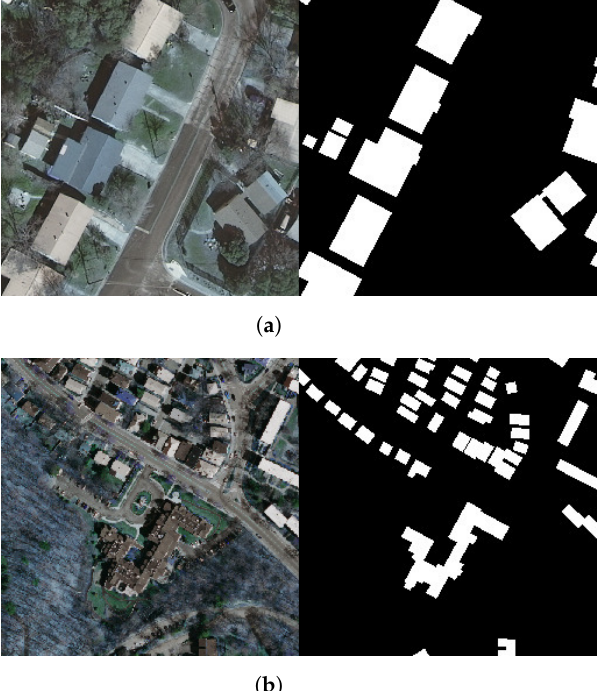
Figure 1. Sample 256 × 256 pixel image and mask: ( a ) Inria dataset, ( b ) Massachusetts